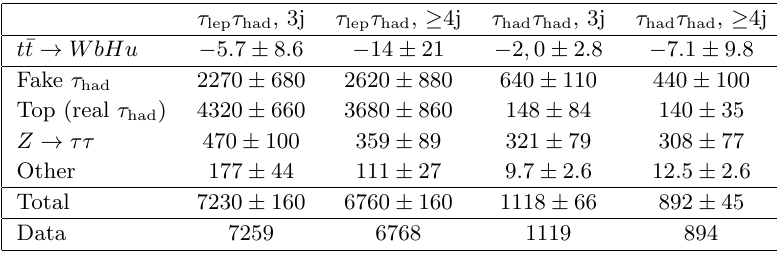
Table 9 . tqH ( (cid:28)(cid:28) ) search: predicted and observed yields in each of the analysis regions considered. The background prediction is shown after the (cid:12)t to data under the signal-plus-background hypothe- sis (assuming t (cid:22) t ! WbHu as signal). The contributions with real (cid:28) had candidates from t (cid:22) t , t (cid:22) tV , t (cid:22) tH , and single-top-quark backgrounds are combined into a single background source referred to as \Top (real (cid:28) had )", whereas the small contributions from Z ! ‘ + ‘ (cid:0) ( ‘ = e; (cid:22) ) and diboson backgrounds are combined into \Other". The quoted uncertainties are the sum in quadrature of statistical and systematic uncertainties of the yields, computed taking into account correlations among nuisance parameters and among